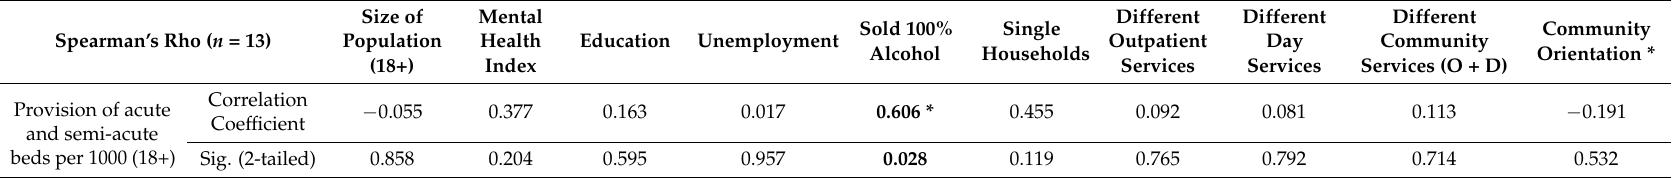
Table 4. Correlations between provision of acute and semi-acute beds (per 1000 18+), socioeconomic factors, need indicators and service